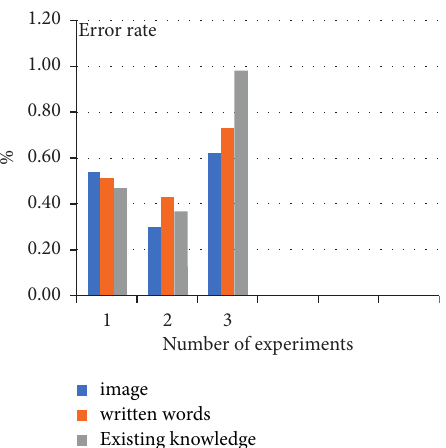
Figure 4: Error histogram of three kinds of parameters in three experiments.